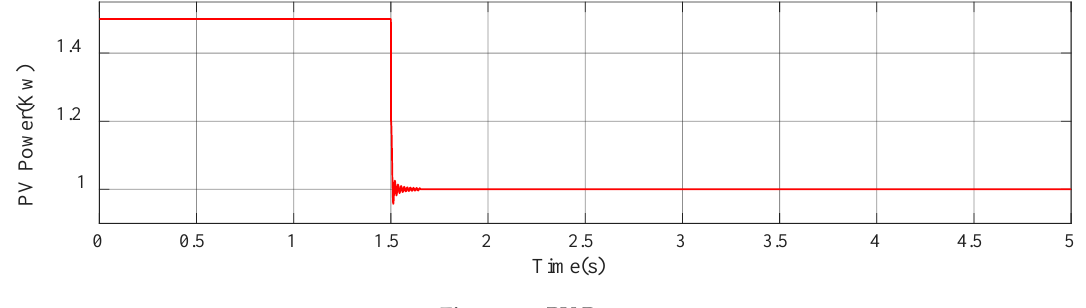
Figure 21. PV Figure 21. PV Power.